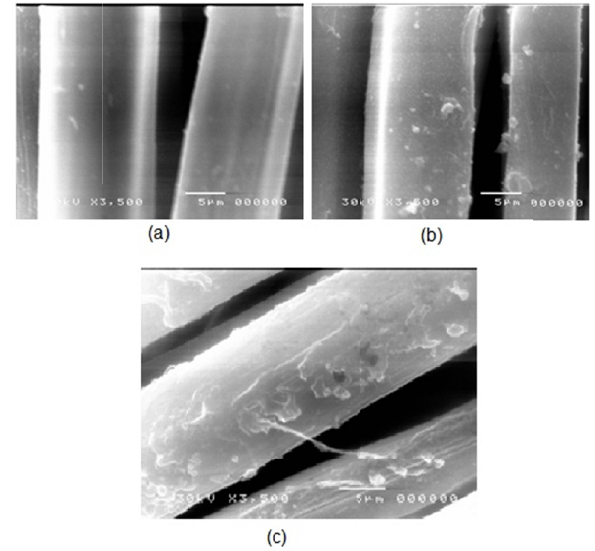
Fig. 4. SEM of untreated and AgNPs-treated silk fabrics with different gamma irradiation doses, a) Original silk fabric, b) 5 kGy, c) 10 kGy.